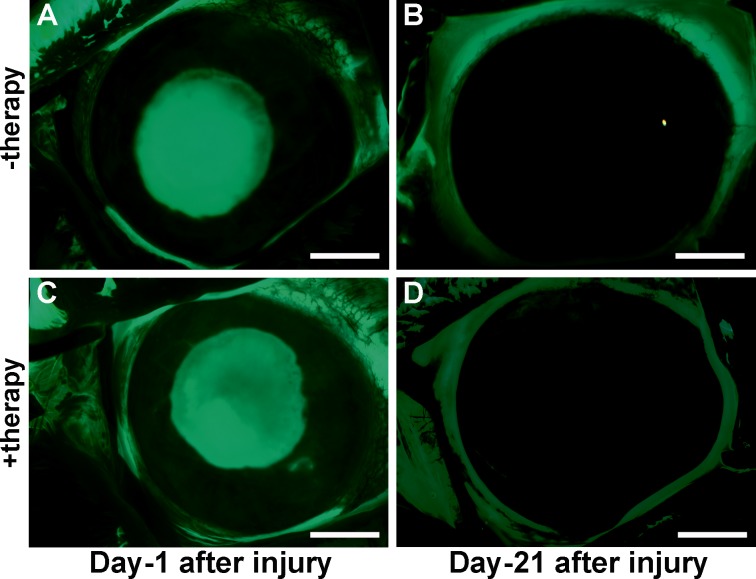
Stereo fluorescence microscopy images on days 1 and 21 post injury of eyes treated with PEI2-GNP alone (A, B) or BMP7+HGF (C, D), showing that therapy does not affect reepithelialization of the injured corneas. Scale bar: 2 mm.